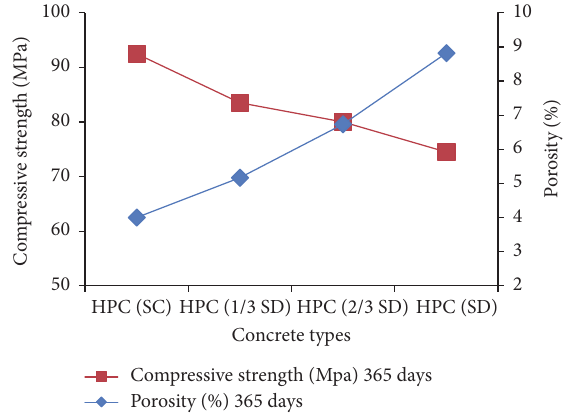
Figure 8: Evolution of mechanical strengths of HPC immersed in potable tap water according to the porosity.